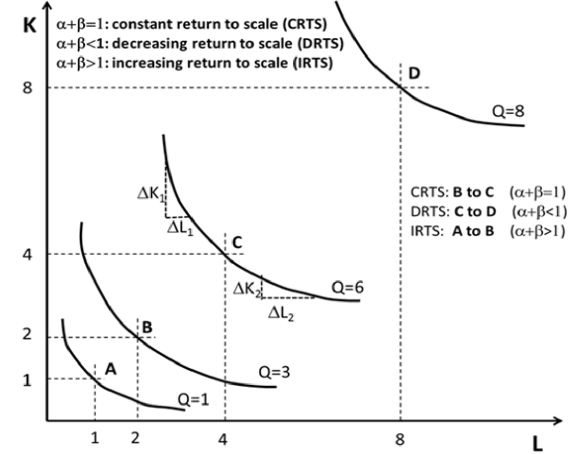
Fig. 1. Illustrative isoquant curves from